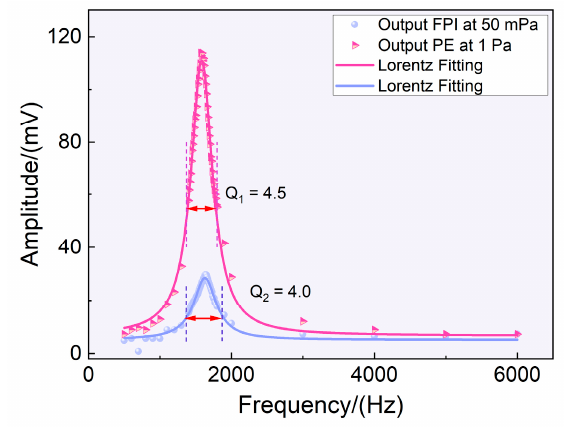
Figure 3. The formant of the FPI and piezoelectric effects.